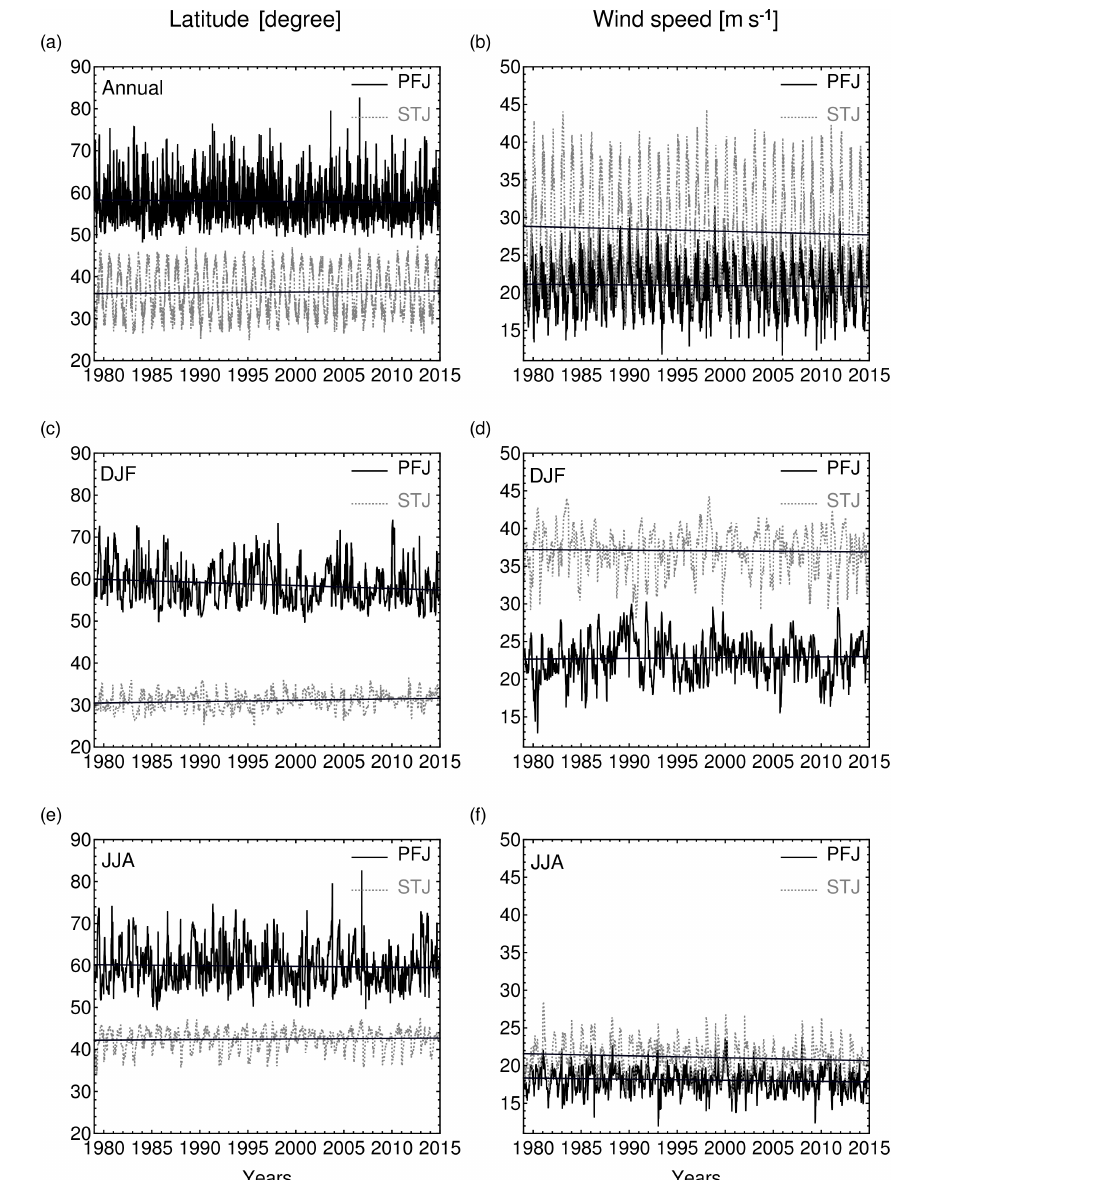
Figure 14. Annual, DJF, and JJA: mean latitudinal trends and mean wind velocity trends of the STJ and PFJ